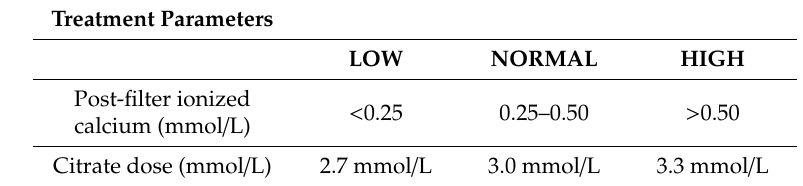
Table 2. Algorithm for the citrate dose management.